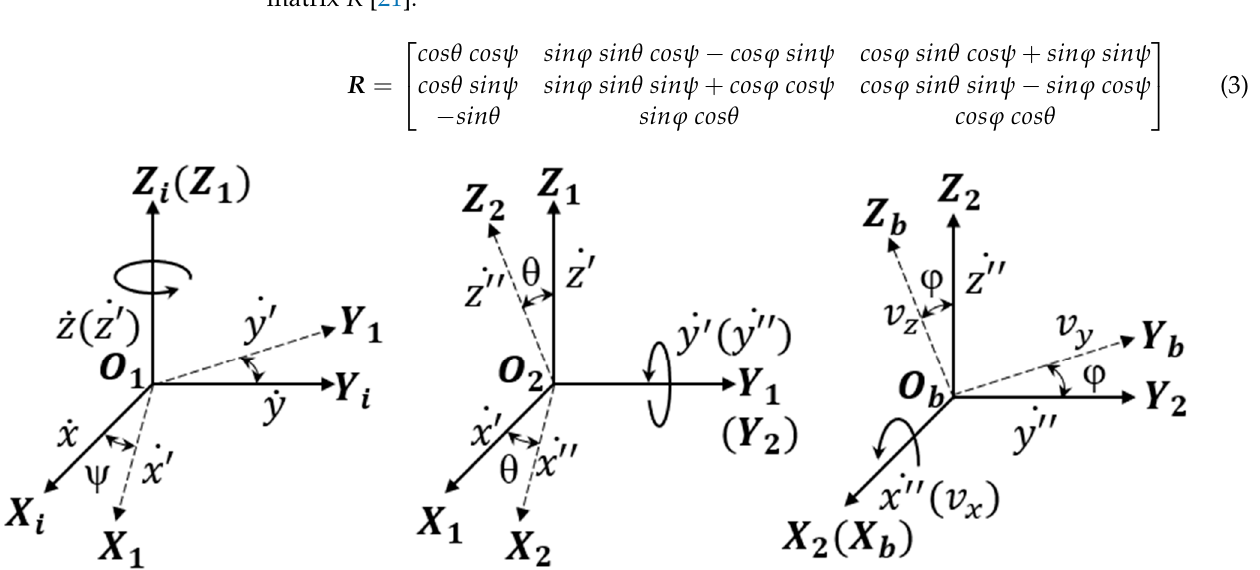
Figure 1. Kinematic scheme of a hexacopter.